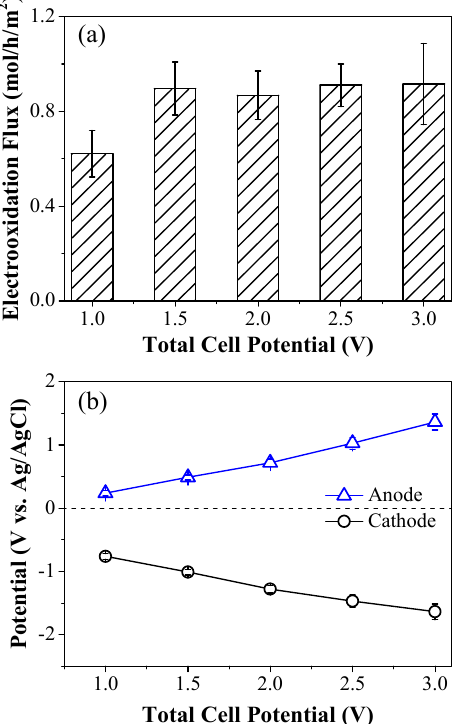
Figure 4. TC electrooxidation flux ( a ) and open-circuit potential ( b ) as a functional total cell potential. Experimental conditions: [CNT] ink = 1.5 mg/mL, [TC] in = 0.2 mmol/L, [Na 2 SO 4 ] = 10 mmol/L, and flow rate = 1.5 mL/min.